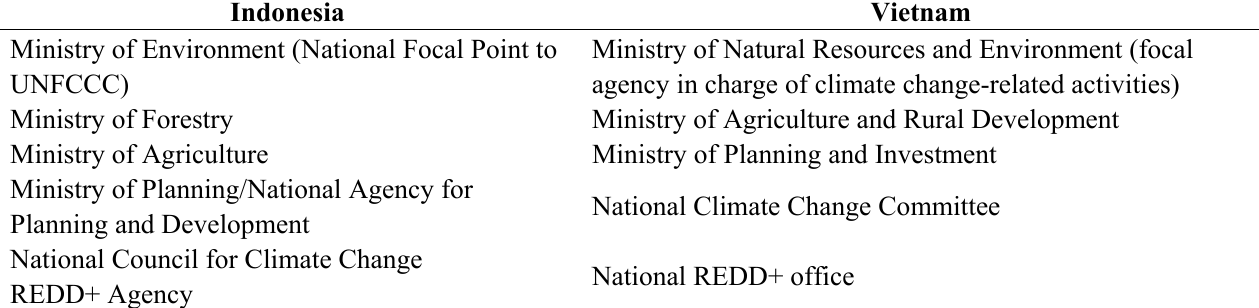
Table 2. Major government agencies in Indonesia and Vietnam with a climate change